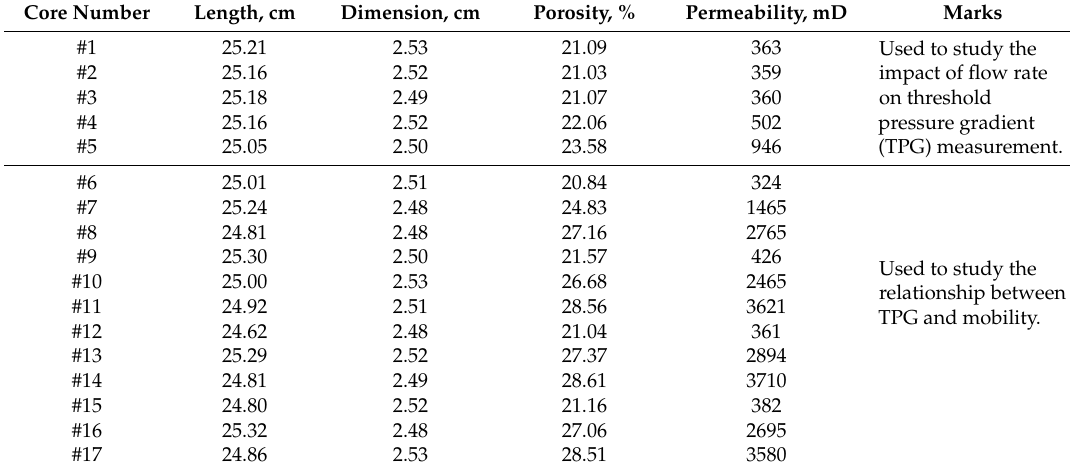
Table 2. The basic parameters of core samples used in this paper. Core Number